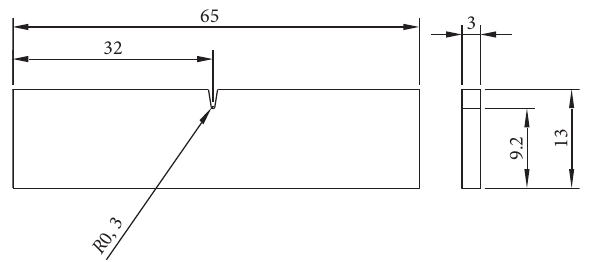
Figure 1: Dimension of test specimen (AutoCAD 2D drawing: all dimensions are in mm).